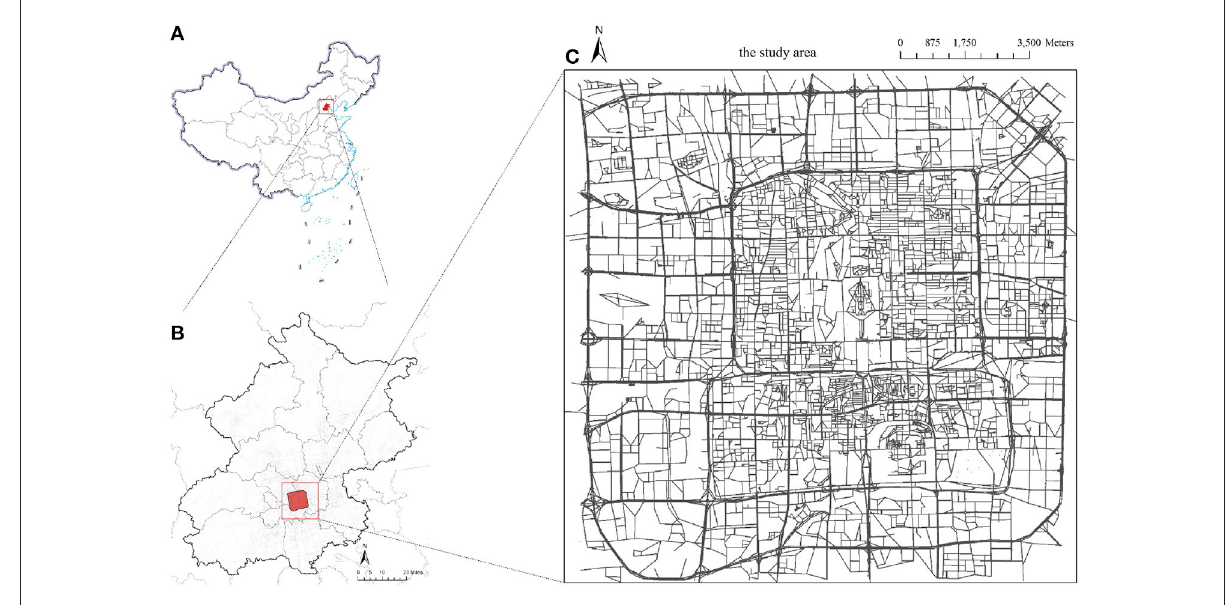
FIGURE8 The study area. (A) China. (B) Beijing. (C) The study area.